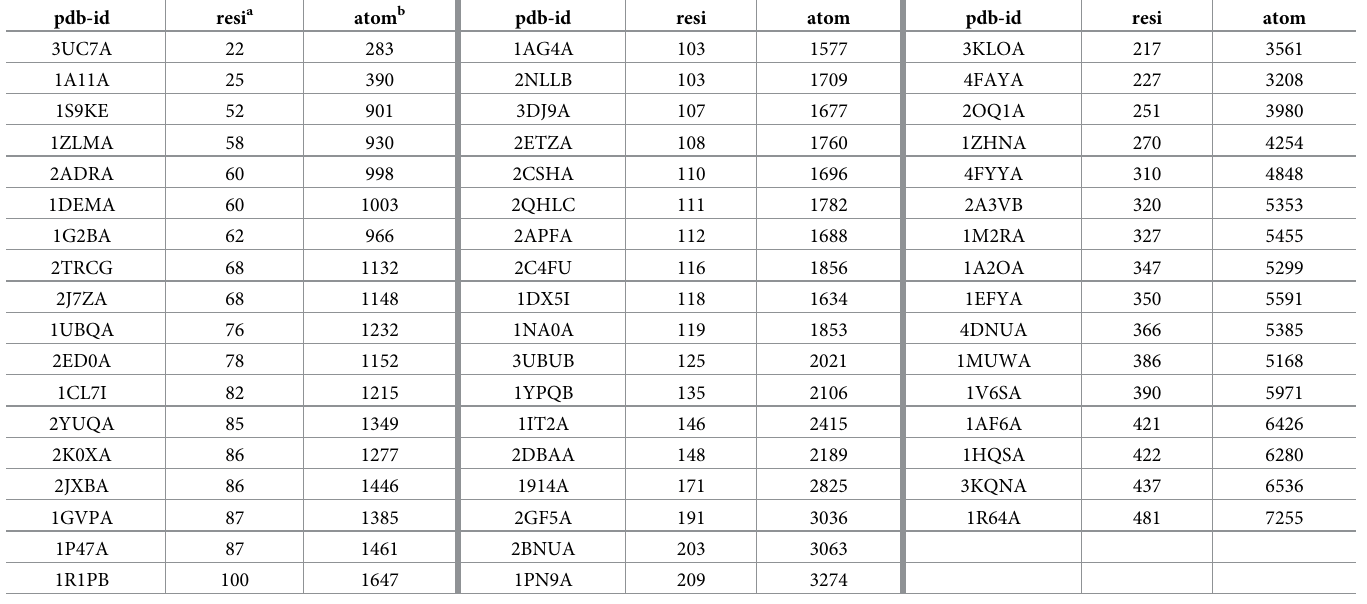
Table 1. List of proteins used in this